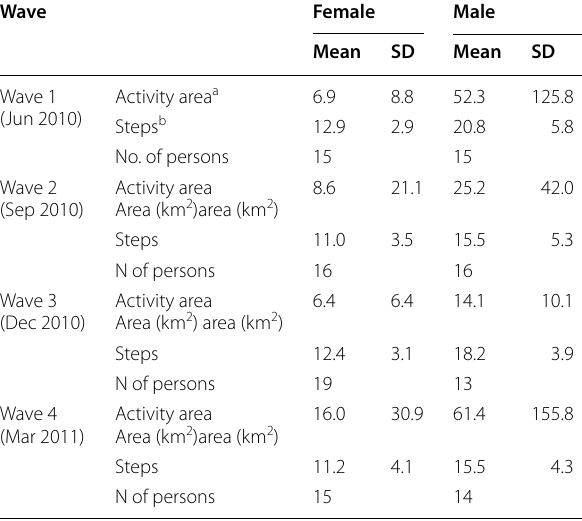
Table 2 Activity space and daily steps by gender and by